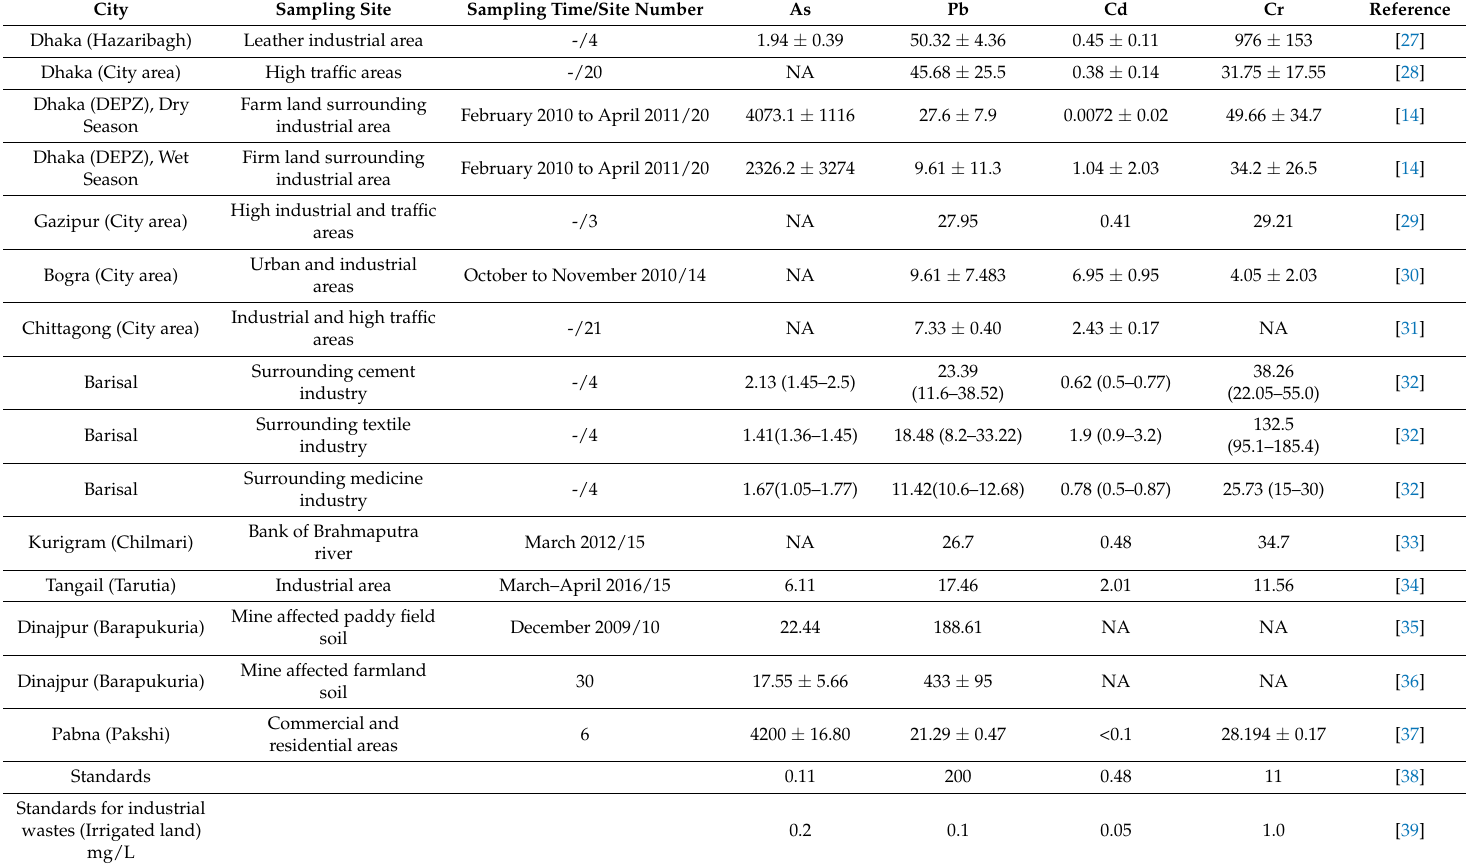
Table 1. Recent reports on heavy metals and metalloids pollution in Bangladesh soil